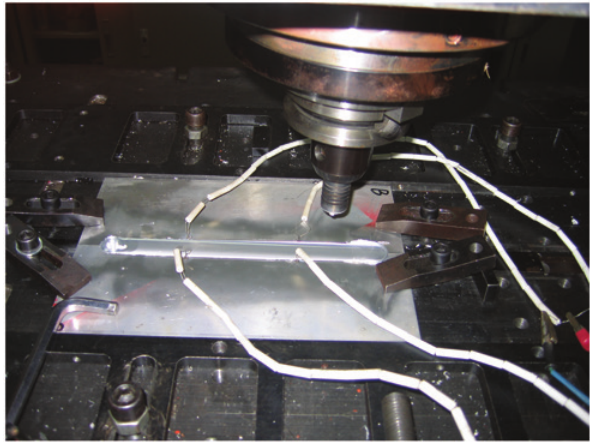
Figure 3: Thermocouples enwrapped by ceramic tube.